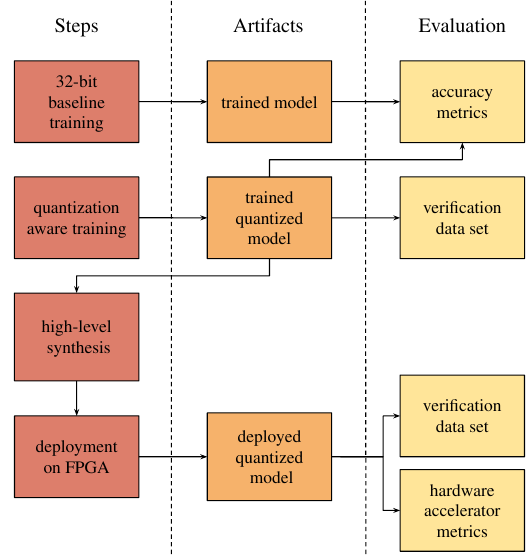
Figure 8. Scheme of proposed workflow.